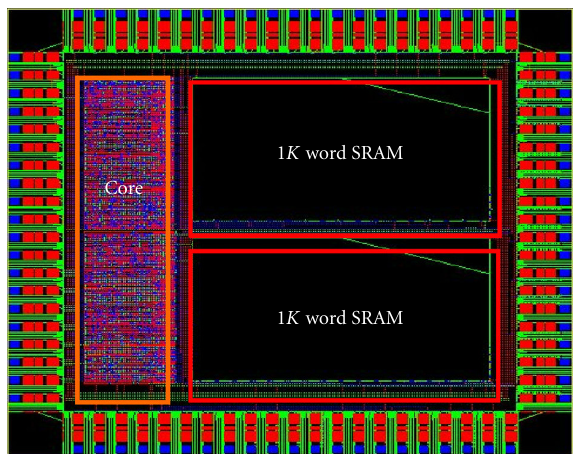
Figure 13: Layout of the FFT/IFFT